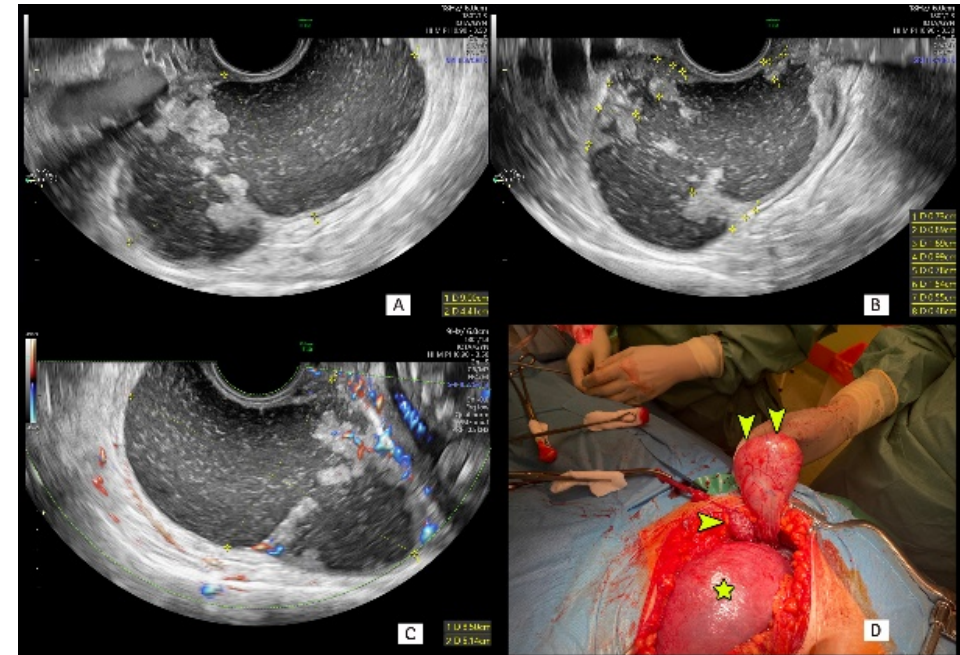
Figure 1. Cystic–solid lesion sonographic and surgical findings in a 36-year-old woman at 26 weeks of gestation. ( A ) Solid–cystic mass is seen in the posterior cul-de-sac with multiple internal papillary projections ( A , B ). Multiple blood vessels are visible in solid parts and papillary projections on color Doppler imaging ( C ). Open laparotomy at 26 weeks of gestation: small metastatic tumor (horizontal arrowhead) near gravid uterus (star, D ) and an intact tumor capsule (vertical arrowheads, D ). Final histology: FIGO stage IIC serous ovarian cancer.